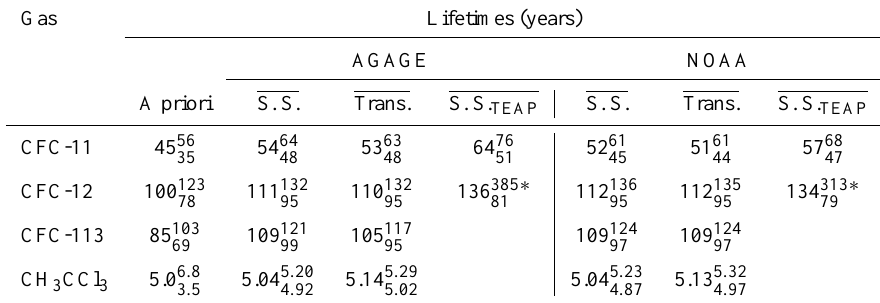
Table 2. A priori and derived lifetimes using AGAGE and NOAA measurements. A priori lifetime uncertainties are the mean aggregated uncertainties in steady-state lifetimes due to each parameter solved for in the inversion (stratospheric loss rates, transport parameters and OH concentration). Optimised lifetimes are shown for inversions using either AGAGE or NOAA data. For each measurement dataset, mean steady-state (S. S.) and transient lifetimes (Trans.) from peak burden onwards are shown. Also shown are mean steady-state lifetimes when UNEP/TEAP emissions were used instead of McCulloch et al. emissions for CFC-11 and CFC-12 (S. S. TEAP ). The optimised lifetime uncertainties include the aggregate influence of inversion parameter uncertainties and emissions uncertainties. Gas Lifetimes (years) AGAGE NOAA A priori S. S. Trans. S. S. TEAP S. S.